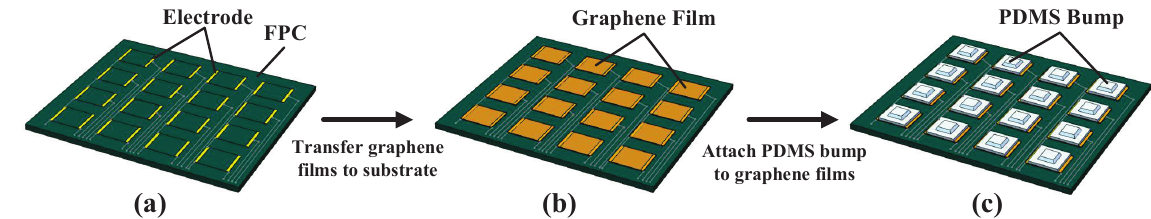
Figure 4. The lower substrate was flexible printed circuit (FPCB) fabricated by MEMS technology ( a ); The graphene films were obtained by CVD method and transfered to the substrate ( b ); The PDMS bump was attched to graphene films ( c ).